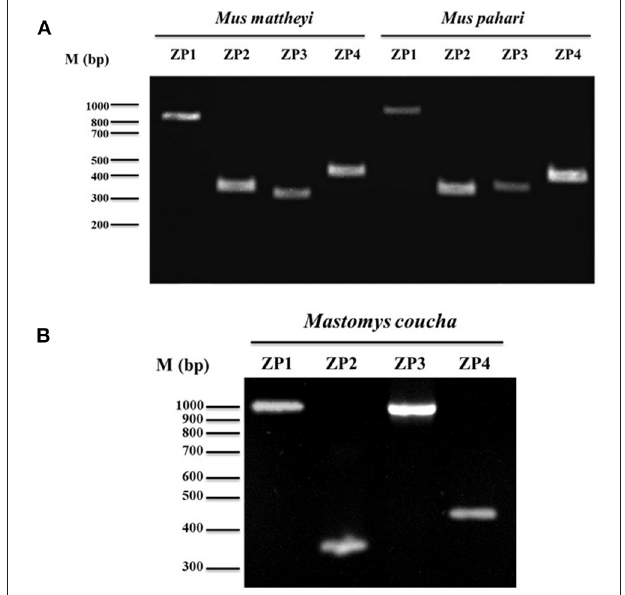
FIGURE 3 | Analysis of Zp1, Zp2, Zp3, and Zp4 gene expression in (A) Mus mattheyi , Mus pahari and (B) Mastomys coucha by RT-PCR. Amplicons corresponding to each gene are shown. Primers used for the amplifications of the different ZP genes are shown in Supplementary Table 2